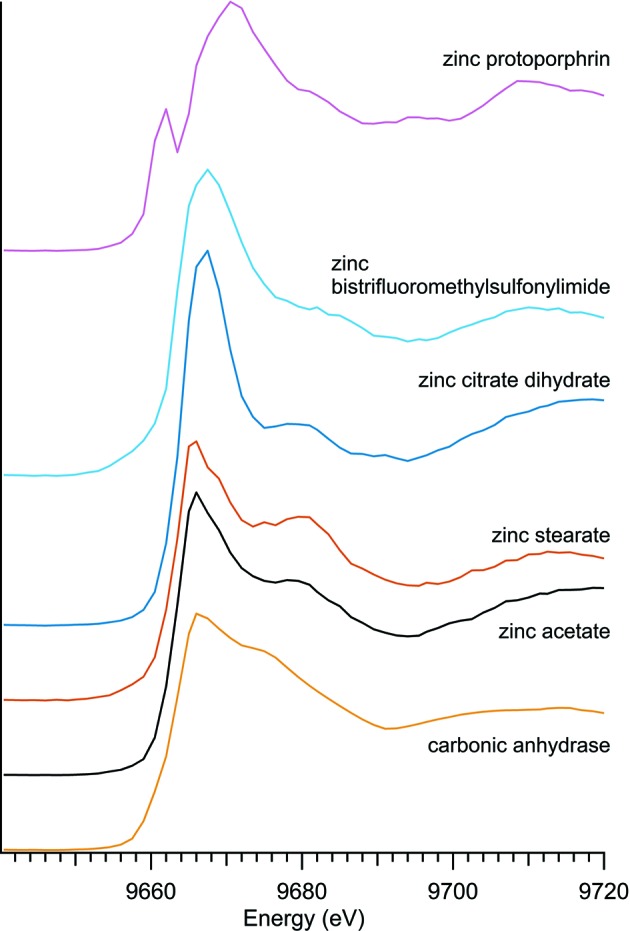
Spectra of organic zinc.